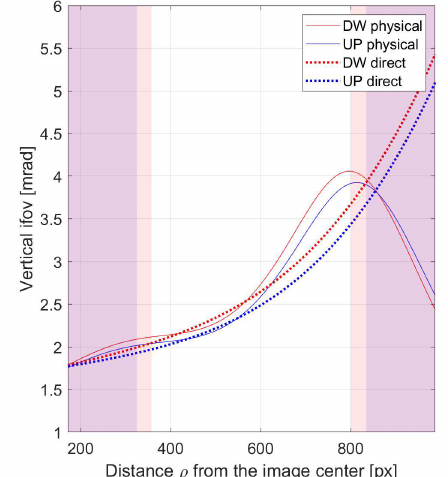
Figure 10 IFoV as a function of the (cid:2251) distance from the center of the camera model for the optical head and both the models considered.